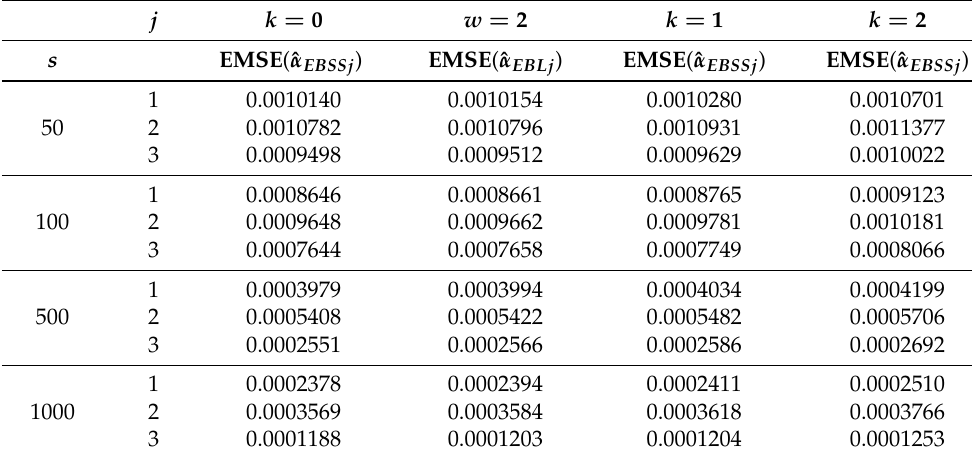
Table 4. Simulated EMSE of ˆ α with n = 72, β = 3, u = 3 and v =